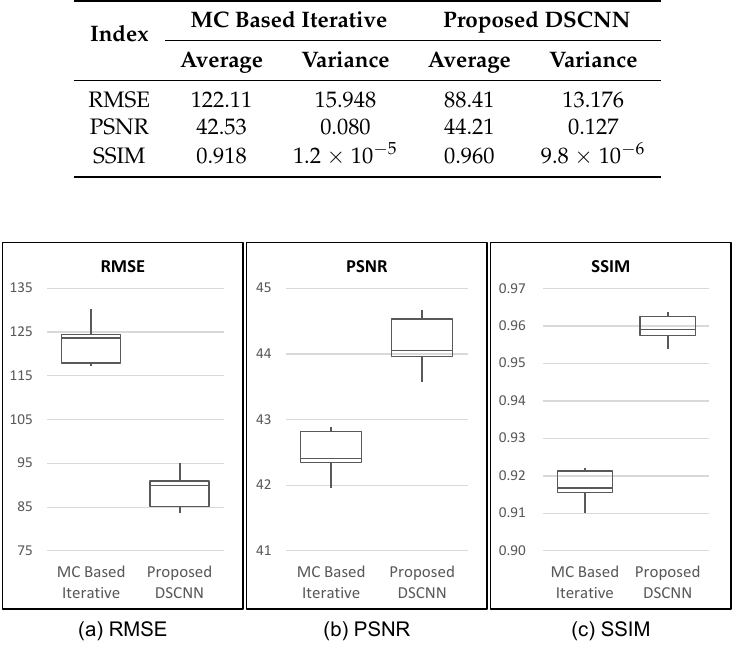
Figure 10. Box and whiskers plots of Table